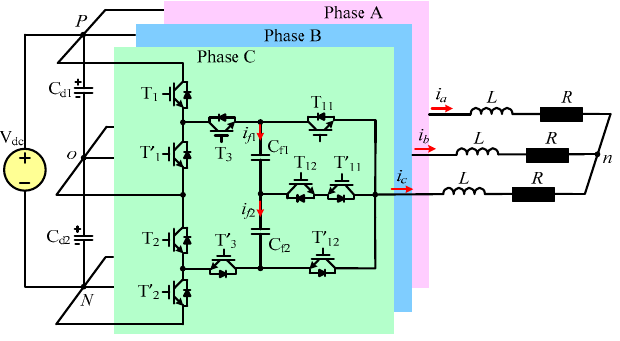
Figure 25. Three ‐ phase hybrid T ‐ ANPC converter connected with RL ‐ load. Figure 25. Three-phase hybrid T-ANPC converter connected with RL -load. Table 6. Operation of 5L hybrid T-ANPC Table 6. Operation of 5L hybrid T ‐ ANPC converter.